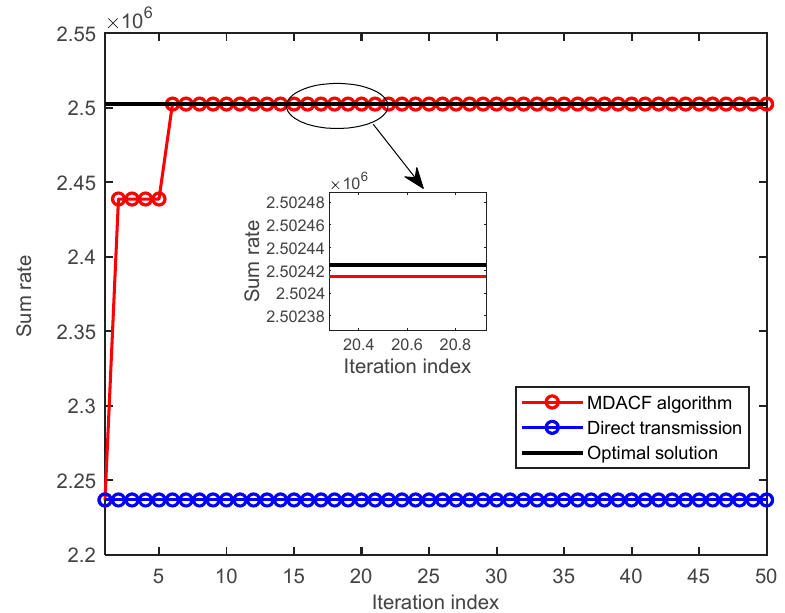
Figure 2. Schematic diagram of the comparison of different algorithms. In order to maximize the transmission rate of users, cooperative transmission is implemented among users through coalition groups. The users forming a coalition use the same channel for transmission. The jammer is located at the origin of the coordinates. Assuming that the initialized coalitions are Co = { Co 1 , Co 2 , Co 3 } , where Co 1 = [ 2 3 4 6 8 ] , Co 2 = [ 1 5 7 ] , and Co 3 = [ 9 10 ] , and coalition 1 is the channel 1 subject to jamming. Figure 3 shows the selection results after the formation of the users’ coalition group. It can be seen that most of the users in channel 1 subject to jamming during initialization leave coalition 1 and join other coalitions, thus avoiding jamming. Furthermore, adopting the coalition strategy reduces the mutual interference among users.